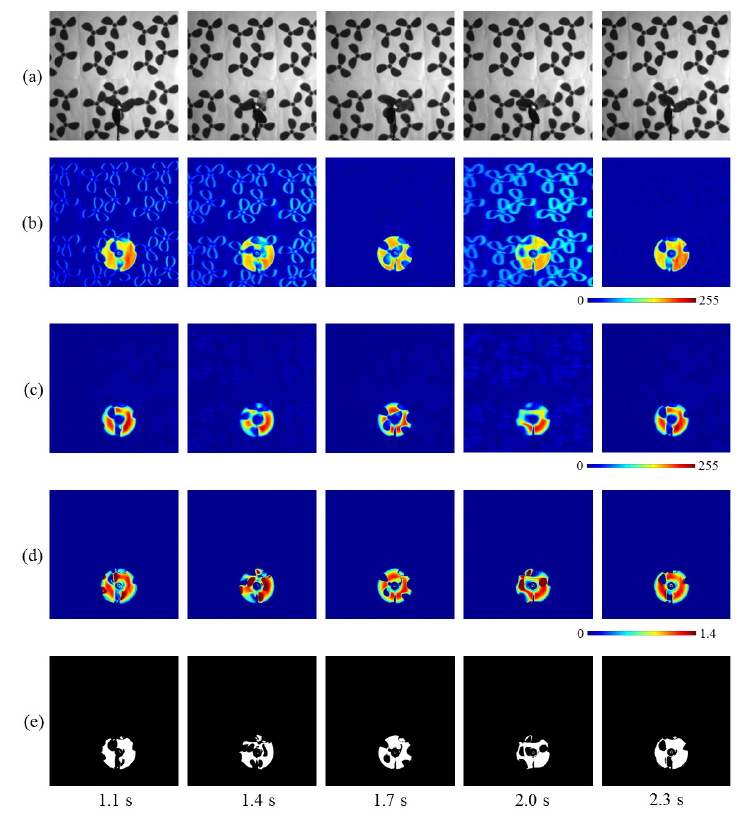
Figure 17. ( a ) Input images; amplitude of ( b ) input; and ( c ) pixel-wise filtered images; ( d ) amplitude ratios; ( e ) extracted vibration features.